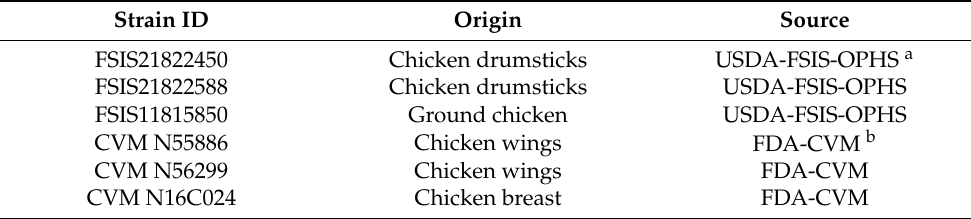
Table 1. Campylobacter jejuni strains used in the